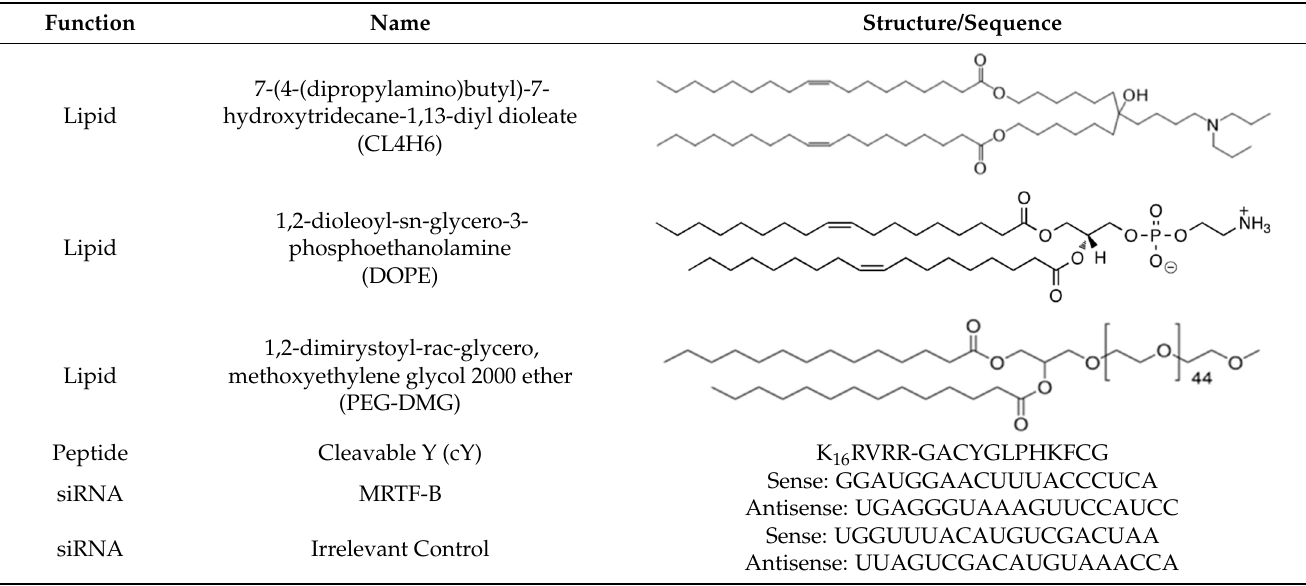
Table 1. Structures of the different lipids and sequences of the peptide and siRNAs.